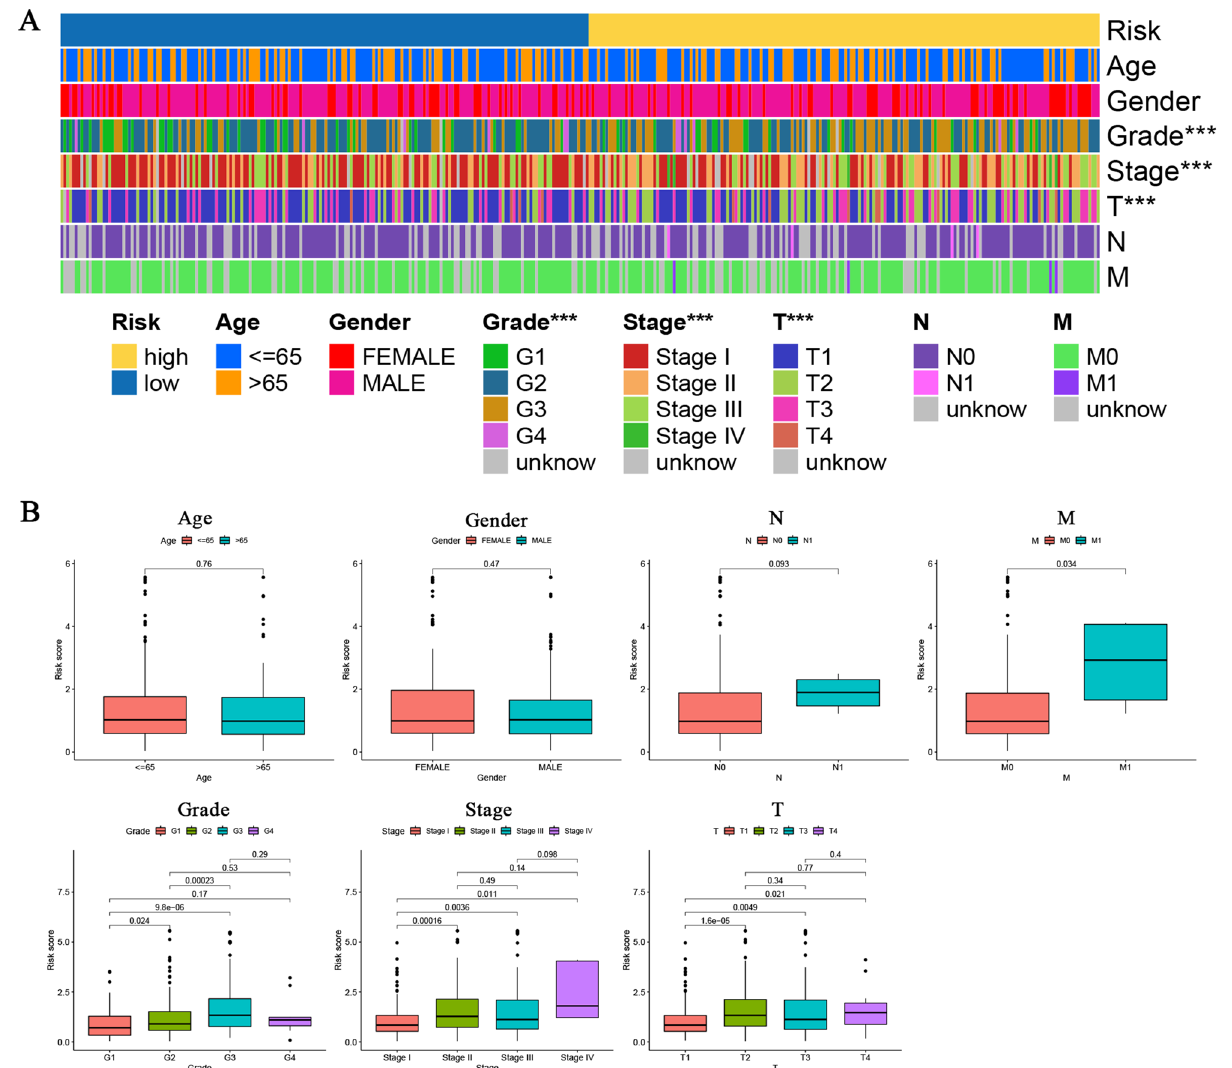
Figure 5. Clinical correlation analysis between the prognostic signature and clinicopathologic features by ( A ) the Chi-square test and ( B ) Wilcox signed-rank test. *** p <